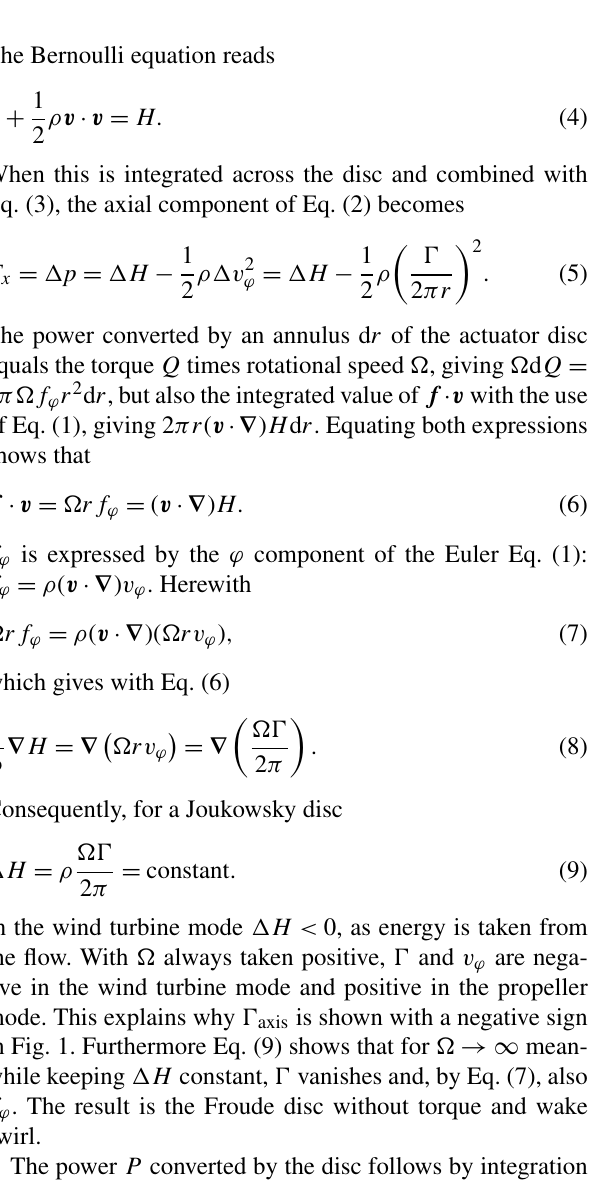
Figure 2. The stream tube of a propeller disc from cross sections A 0 , infinitely far upstream, to A 1 in the fully developed wake. Only the upper half of the stream tube is